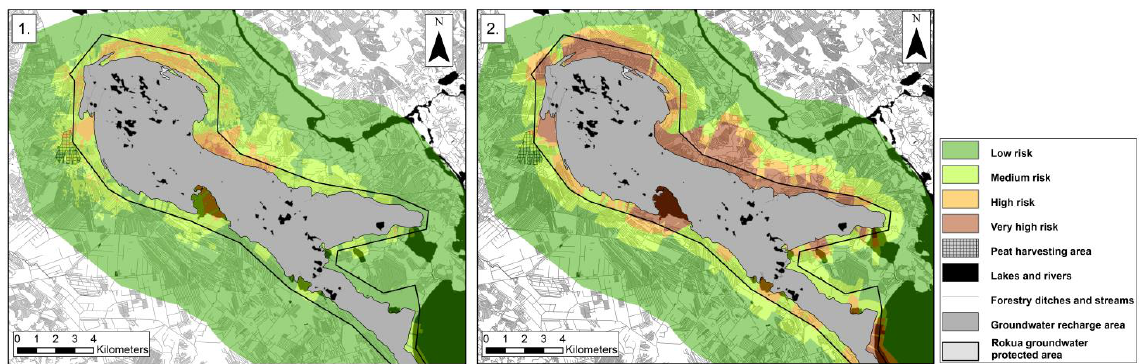
Fig. 4. Groundwater exfiltration risk analysis maps for Rokua with different data sets. In Map 1, risk analysis was based on terrain slope, distance from the recharge zone and springs, and peat thickness. In Map 2, peat thickness was not